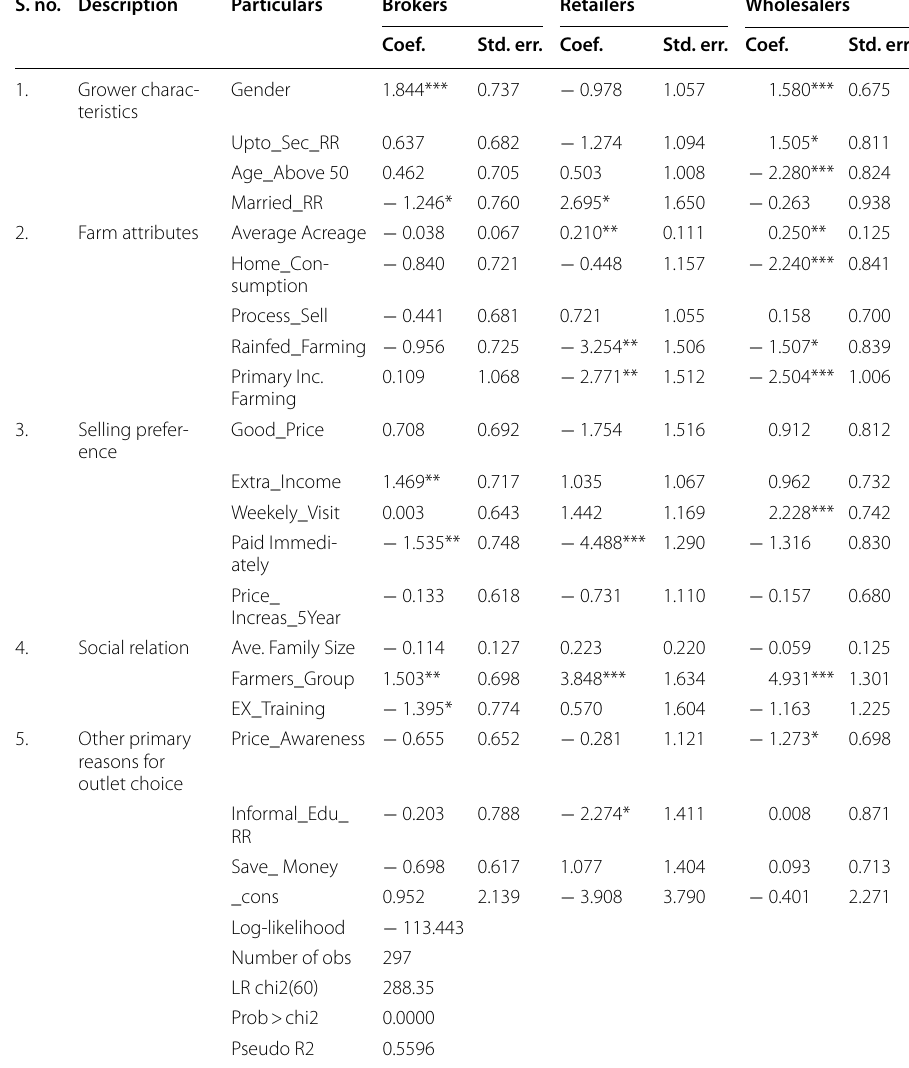
***1%, **5% and *10% significant